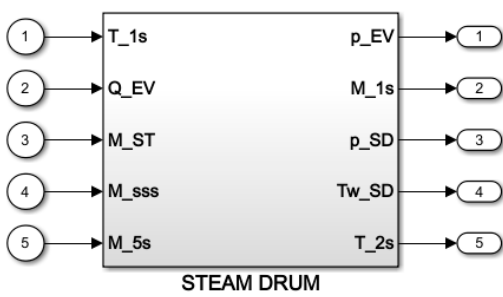
Figure 3. Steam Drum (SD) Matlab-Simulink module.